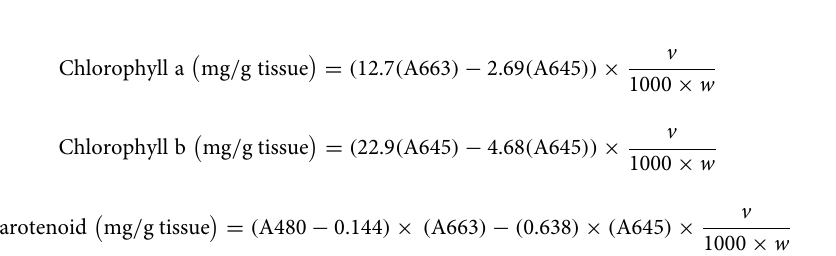
Figure 10. Newly developed temporary immersion bioreactor system. ( a ) Nutrient reservoir, ( b ) growth chamber, ( c ) silicon stopper, ( d ) air compressor. (Line drawing using AutoCAD 2015 version; Image was arranged using Microsoft